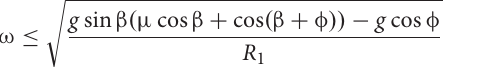
the seed guide belt. The seeds are affected by the spatial force system composed of the centrifugal force F c , the supporting force of the blade F n , the friction force of the blade F s and the seed gravity G